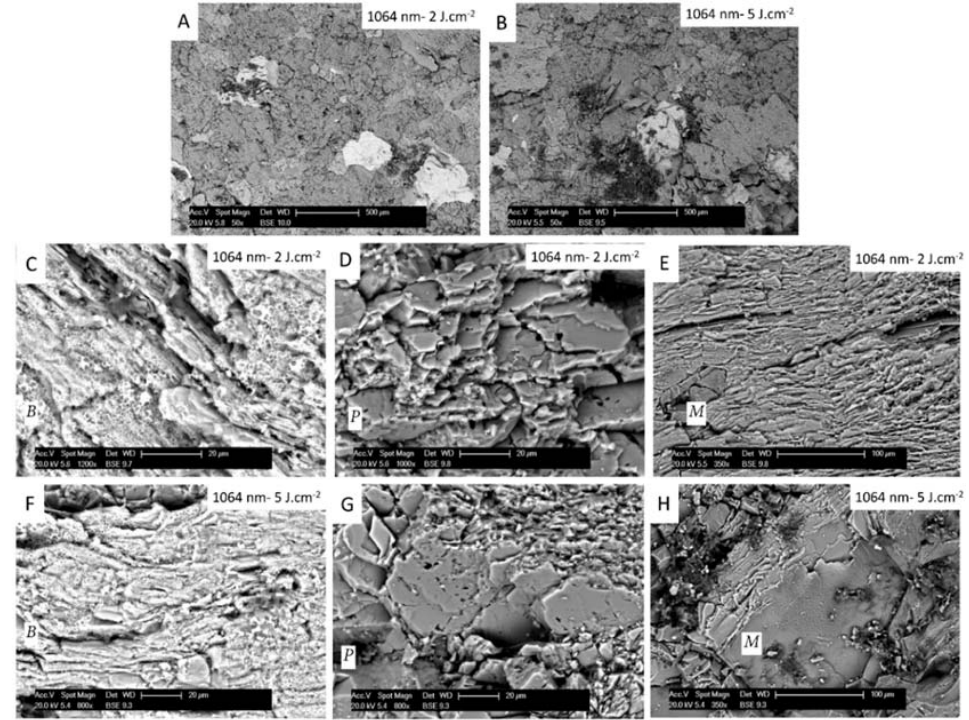
Figure 8. SEM micrographs of the treated surfaces with an Nd:YAG laser working at 1064 nm at two different fluences (2 and 5 J ∙ cm − 2 ). B: biotite, P: plagioclase, F: feldspar, M: muscovite.